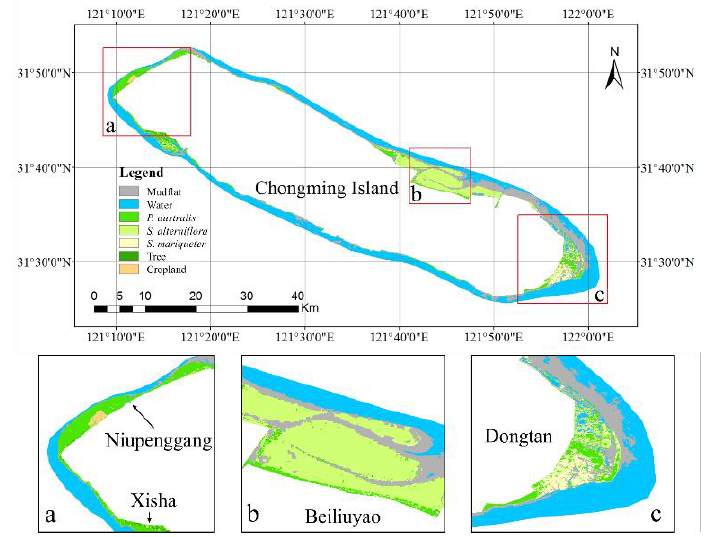
Figure 10. The classification of the green period under the proper feature combination. Subfigure ( a ) shows the Xisha and Niupenggang areas, subfigure ( b ) shows the Beiliuyao area, and subfigure ( c ) shows the Dongtan area.